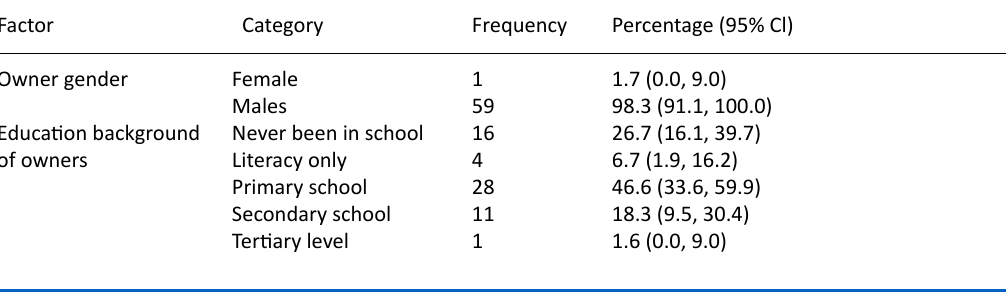
Table 1. Descriptive analyses of socio demographic characteristics of the respondents (sheep owners)